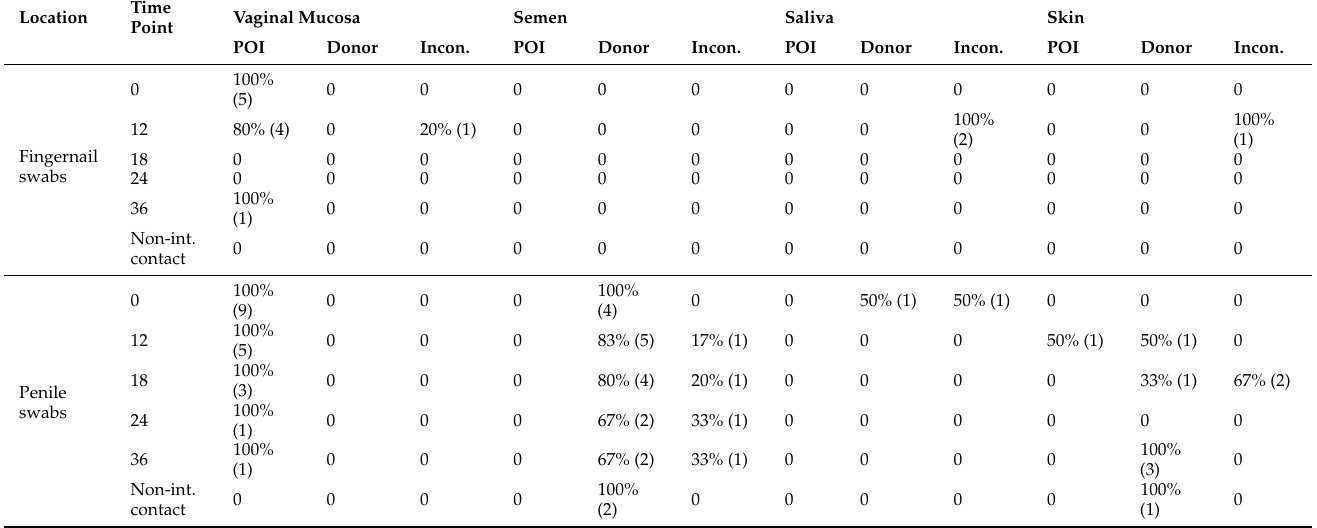
Table 2. The percentage of samples (exact numbers in brackets) positive for vaginal mucosa,